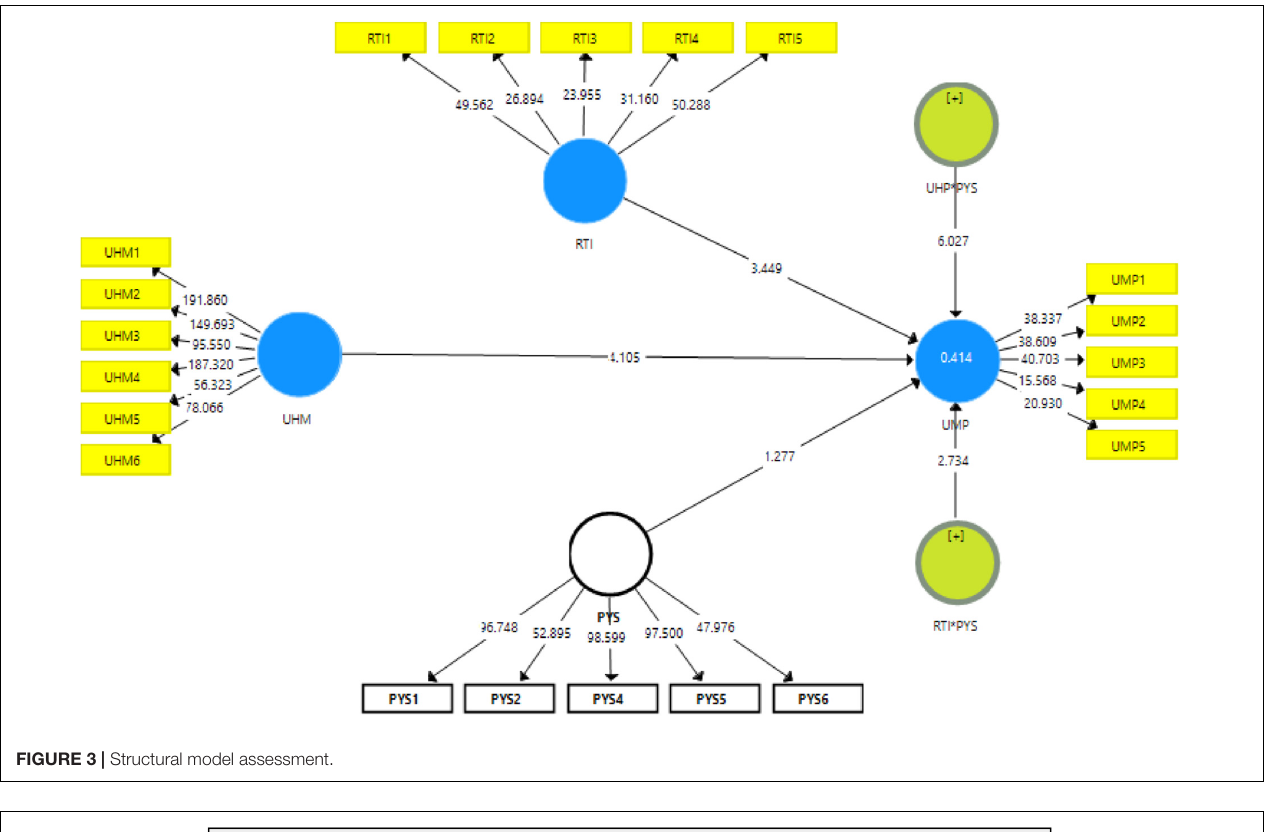
FIGURE 3 | Structural model assessment.